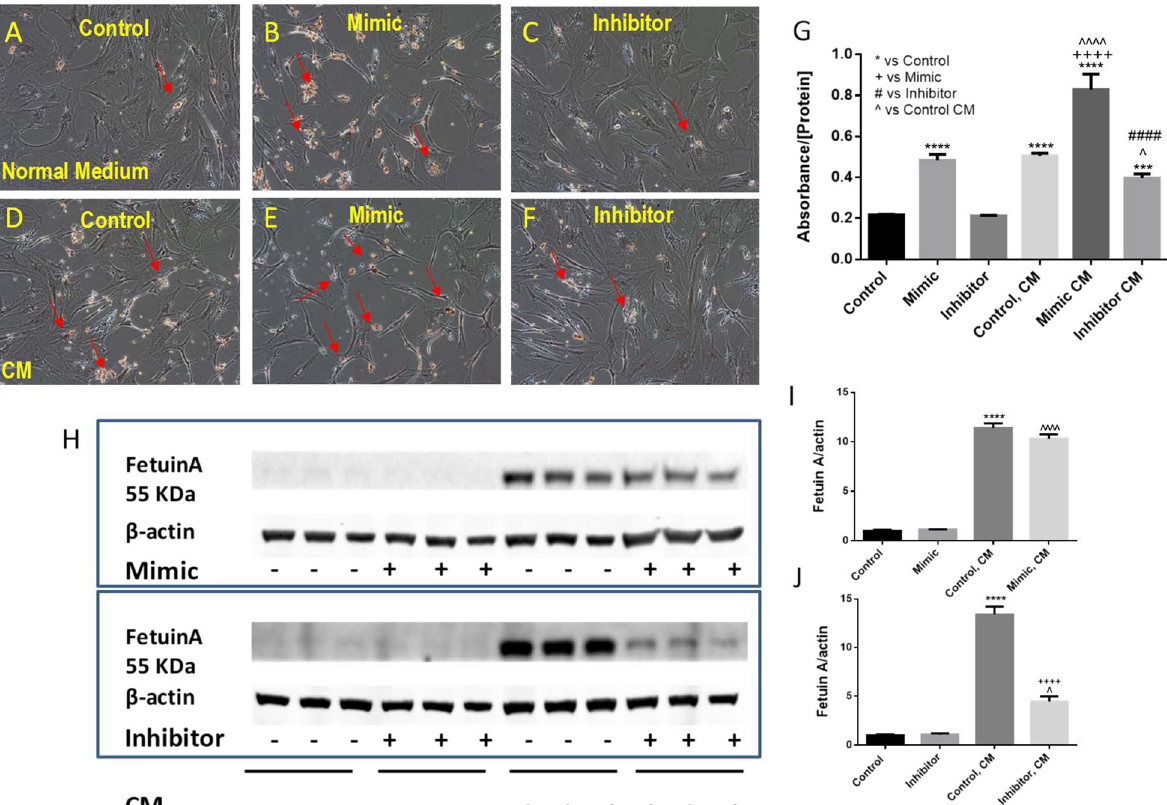
Fig. 2 miR-101-3p mimic promoted HAVICs calcification and inhibition of miR-101-3p protected HAVICs from calcification in CM. Alizarin red staining ( A – F ) of HAVICs cultured in osteogenic-conditioned media (10 mM βGP, 5 mM CaCl 2 ) for 14 days after transfected with miR-101-3p mimic, inhibitor and negative control. G Quantification of alizarin red staining, absorbance normalized by protein concentration. *P < 0.05, ***P < 0.001 and ****P < 0.0001 vs Control; ++++ P < 0.0001 vs Mimic; ^P < 0.05, ^^^^P < 0.0001 vs Control, CM; #### P < 0.0001 vs Inhibitor. H Western blot analysis of Fetuin A protein expression in HAVICs cultured in CM for 48 h after miR-101 mimic/inhibitor transfection. β-actin serves as internal loading control. I , J Quantification of Fetuin A protein expression normalized by β-actin. Data means SEM. ****P < 0.0001 vs Control; ^P < 0.05 and ^^^^P < 0.0001 = ± vs Mimic or Inhibitor groups; ++++ P < 0.0001 vs Control, CM. n 3 =